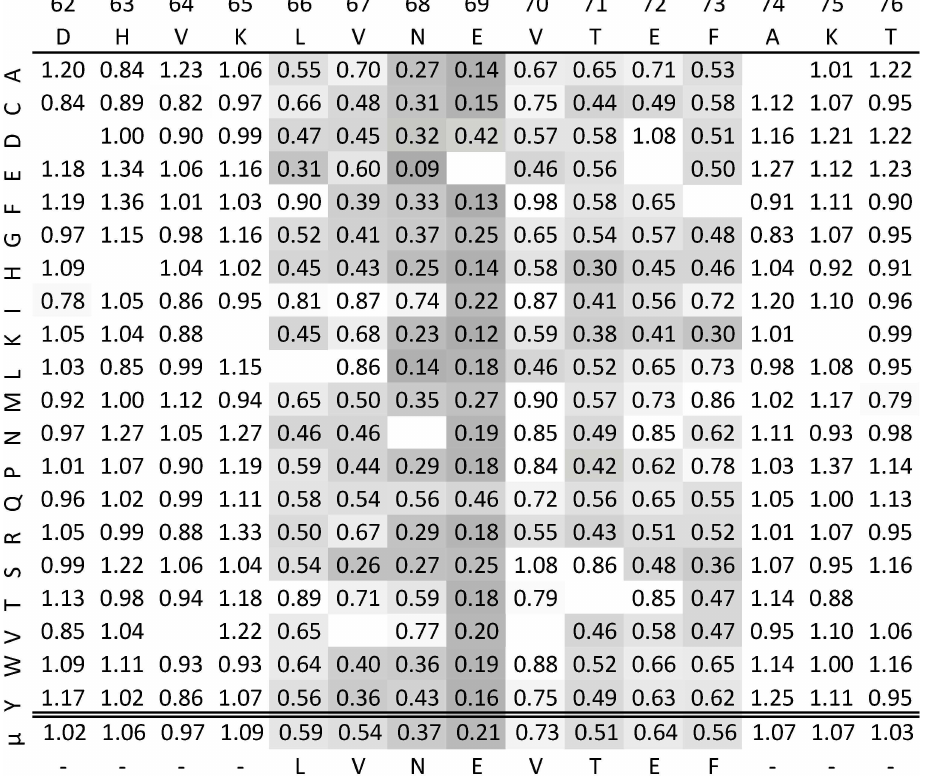
Fig 3. Example of a position specific scoring matrix. The table shows the individualsubstitutionvalues for the peptideDHVKLVNEVTEFAKT through all 15 positions(columns)with all 20 amino acids (rows). The last row shows the mean substitutionvalue of the positions.Blank cells are native amino acids. A Dunnett’sLSD of 0.1741was calculatedon the chosen p < 0.0001level and cells exceedingthis difference are highlighted with a gray gradient(weak to strong effects). The identifiedepitopeis